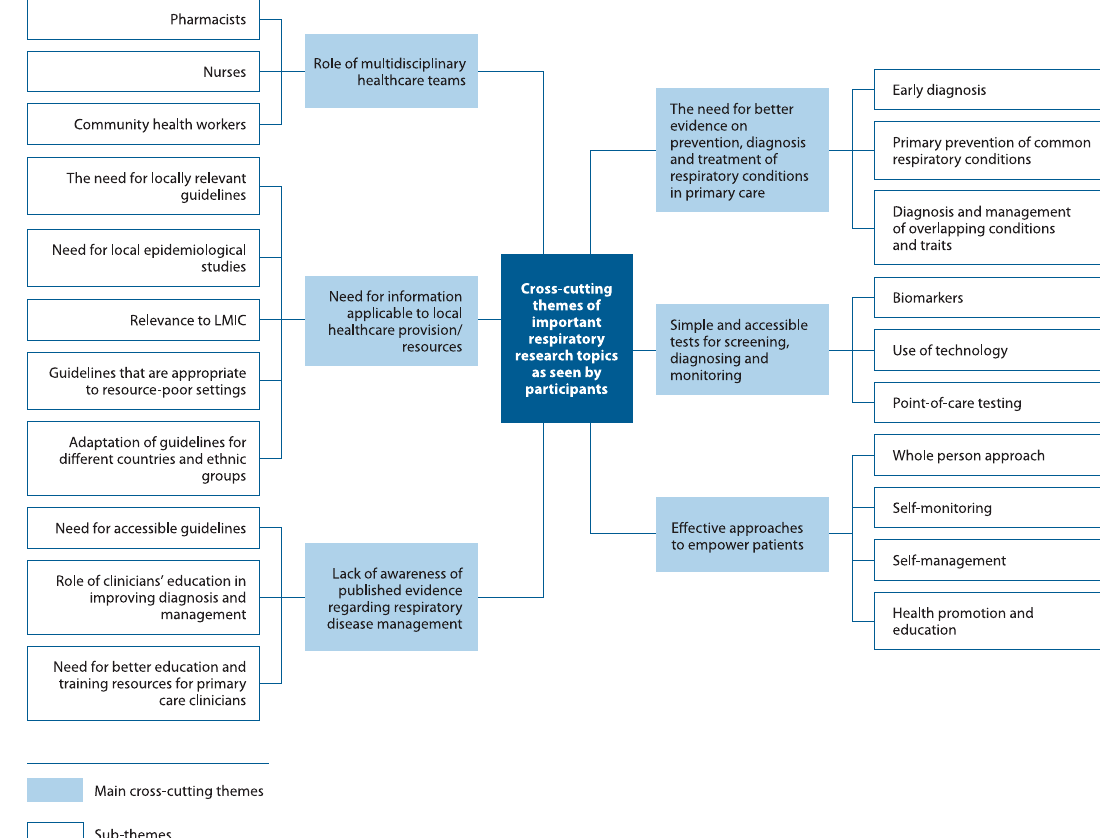
Fig. 4 Summary of the 6 themes and sub-themes from the qualitative analysis of research